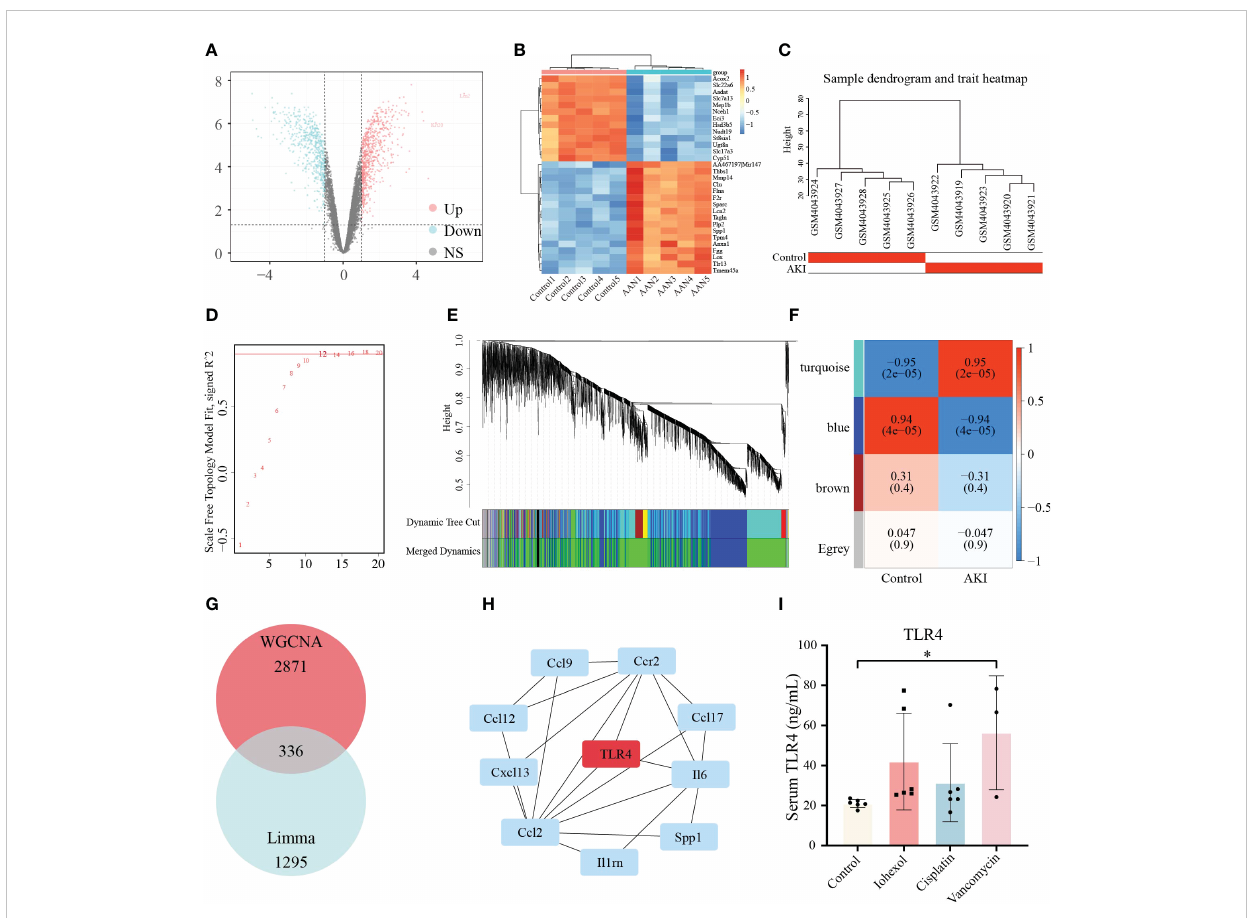
FIGURE 9 Validation of the hub genes in AAN datasets. (A) Volcano plots of DEGs identi fi ed from AAN datasets. Red dots represent up-regulated DEGs whereas blue dots represent down-regulated DEGs. (B) Heatmap of top 30 DEGs rated by P-Value identi fi ed in AAN datasets. (C) Sample dendrogram and trait heatmap show the degree of outliers and grouping information of samples. (D) The “ soft ” threshold based on the scale independence and average connectivity. (E) Gene co-expression modules represented by different colors under the hierarchical clustering tree. (F) Heatmap of the association between modules and AKI. The turquoise module was shown to be correlated signi fi cantly with AKI. Numbers at the top and bottom brackets represent the correlation coef fi cient and P-value , respectively. (G) The Venn diagram shows the intersection of genes in turquoise module and DEGs. (H) The line diagram indicates fi rst ten hub genes results obtained by EcCentricity algorithm in Cytohubba plugin. (I) TLR4 protein levels in patients with iohexol-, cisplatin- and vancomycin- induced AKI compared with healthy controls. Compared with the control group, * p < 0.05.